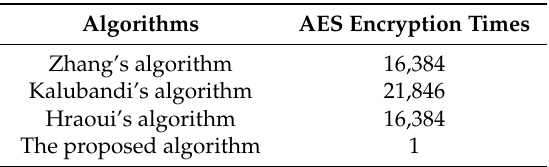
Table 6. Comparison on the AES encryption times (unit: